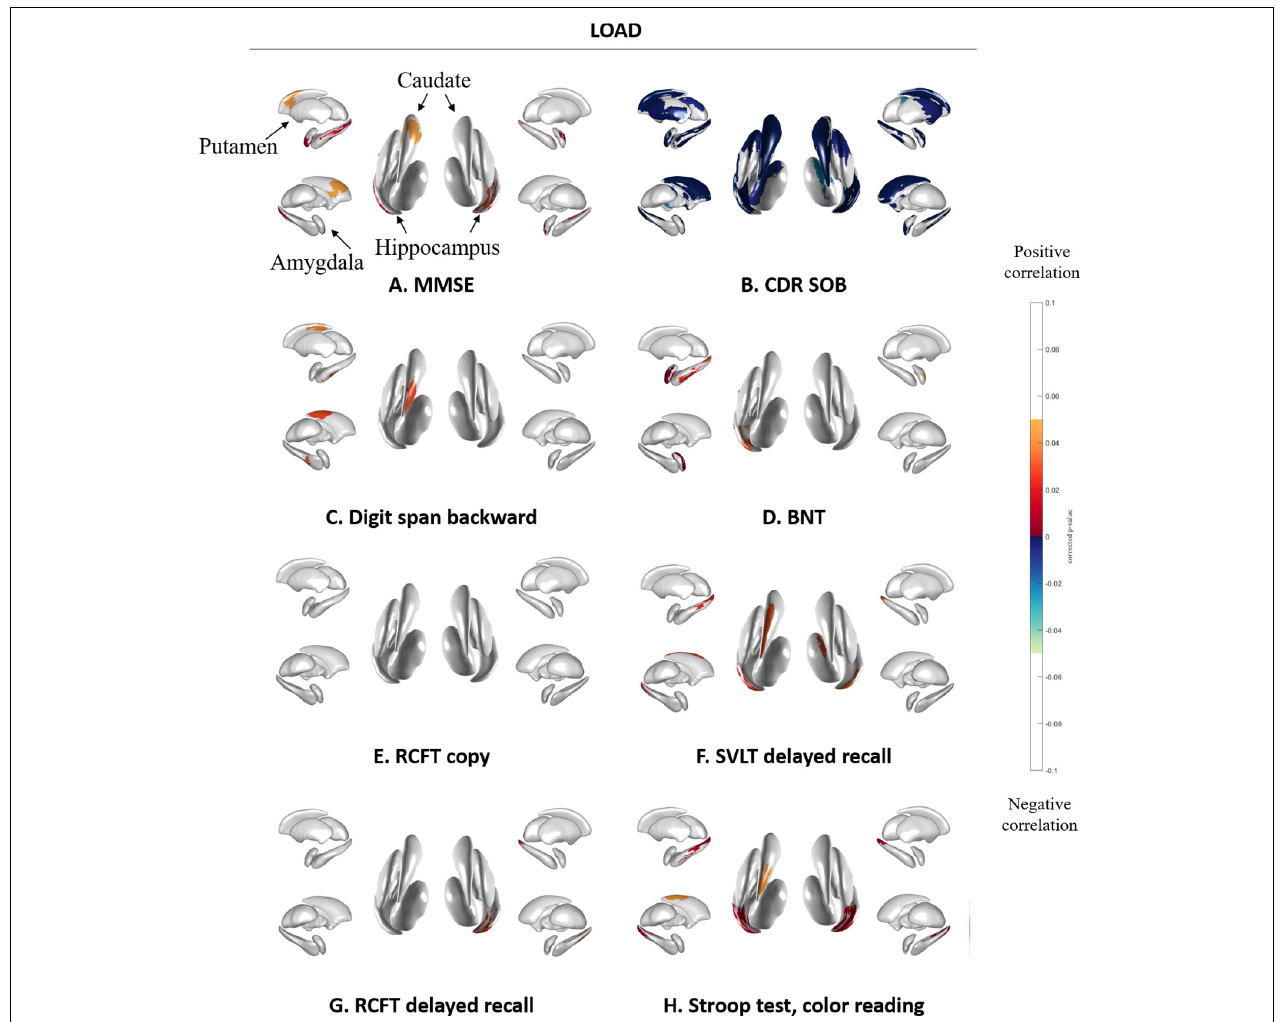
FIGURE 4 | Spearman correlation between neuropsychological test results and subcortical local shape in LOAD group adjusted with intracranial volume. (A) MMSE, (B) CDR-SOB, (C) digit span backward score in attention, (D) BNT score in language, (E) RCFT copy score in visuospatial, (F) SVLT delayed recall score in memory, (G) RCFT delayed recall score in memory, and (H) color reading test score in frontal/executive function. The mapped p -values are multiple corrected using cluster-based statistics. Abbreviations: LOAD, late onset Alzheimer’s disease; MMSE, mini-mental state examination; CDR-SOB, clinical dementia rating-sum of